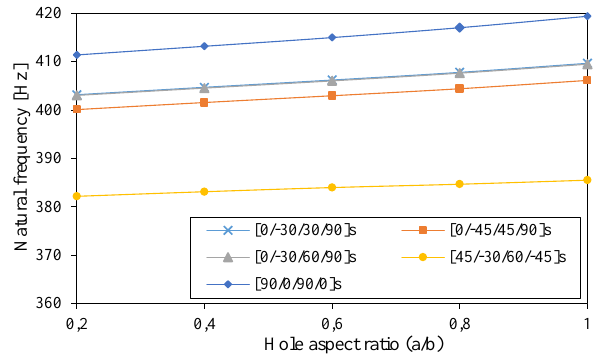
Figure 5: Effect of a/b ratio on the variation of natural frequency ( ϕ = 45; BC = CCCC)